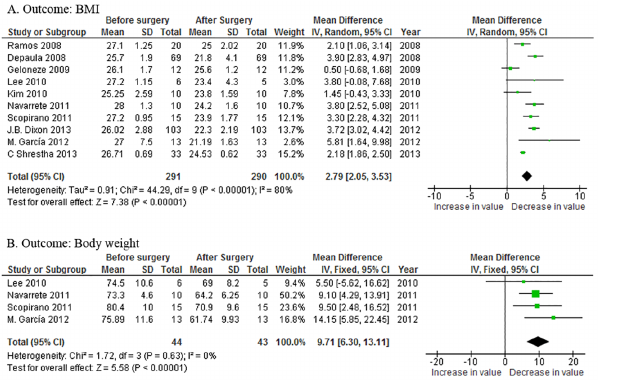
doi:10.1371/journal.pone.0132335.g002